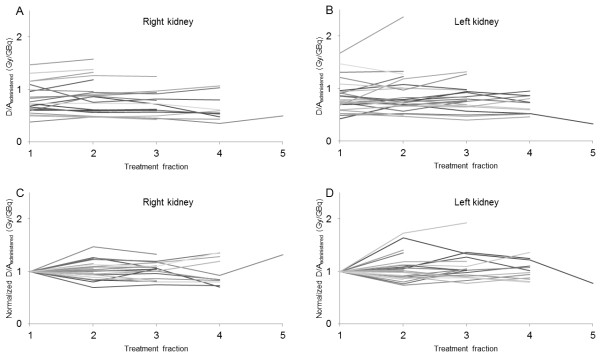
The mean absorbed dose per unit administered activity for each treatment cycle in each patient. The mean absorbed dose per unit administered activity given to (A) right kidney and (B) left kidney for each treatment cycle in each patient. The mean absorbed dose per unit administered activity normalized to the value for the first treatment cycle given to (C) right kidney and (D) left kidney for each patient. Each line corresponds to one patient and the different colors are used to help the reader to follow at least some of the lines to better see different patterns.